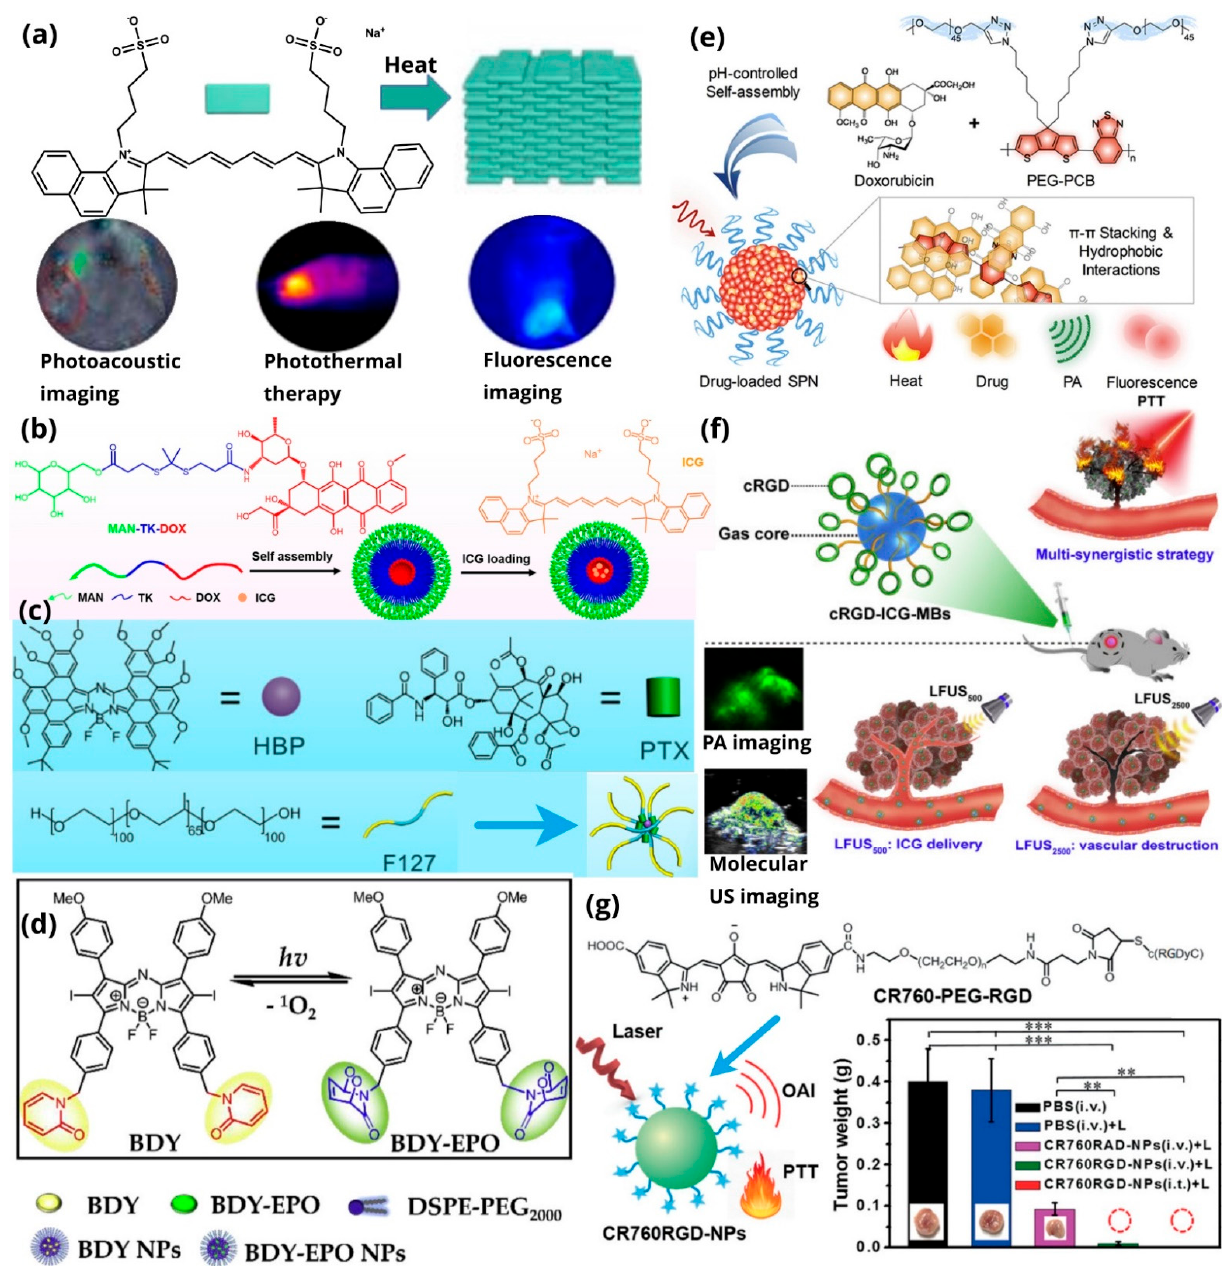
Figure 16. ( a ) Schematic illustration of the formation of ICG J-aggregate. Adapted with per- mission from [70], Nanotheranostics, 2017; ( b ) schematic illustration of ICG, light/ROS